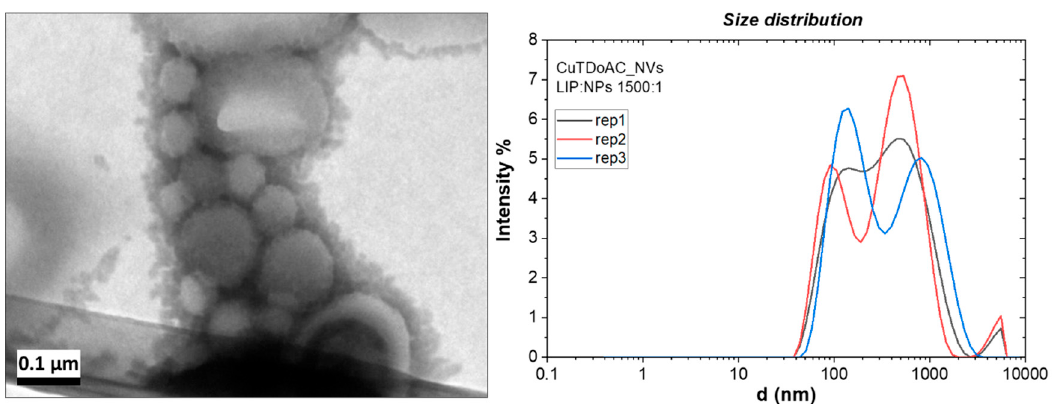
Figure 4. TEM image ( left ) and three dynamic light scattering (DLS) ( right ) replicate measurements of the Cu@TDoAC–NV hybrids prepared at optimized conditions: relative amount of lipid to nanoparticles(LIP:NPs) ratio 1500:1 w/w . nanoparticles(LIP:NPs) ratio 1500:1 w / w